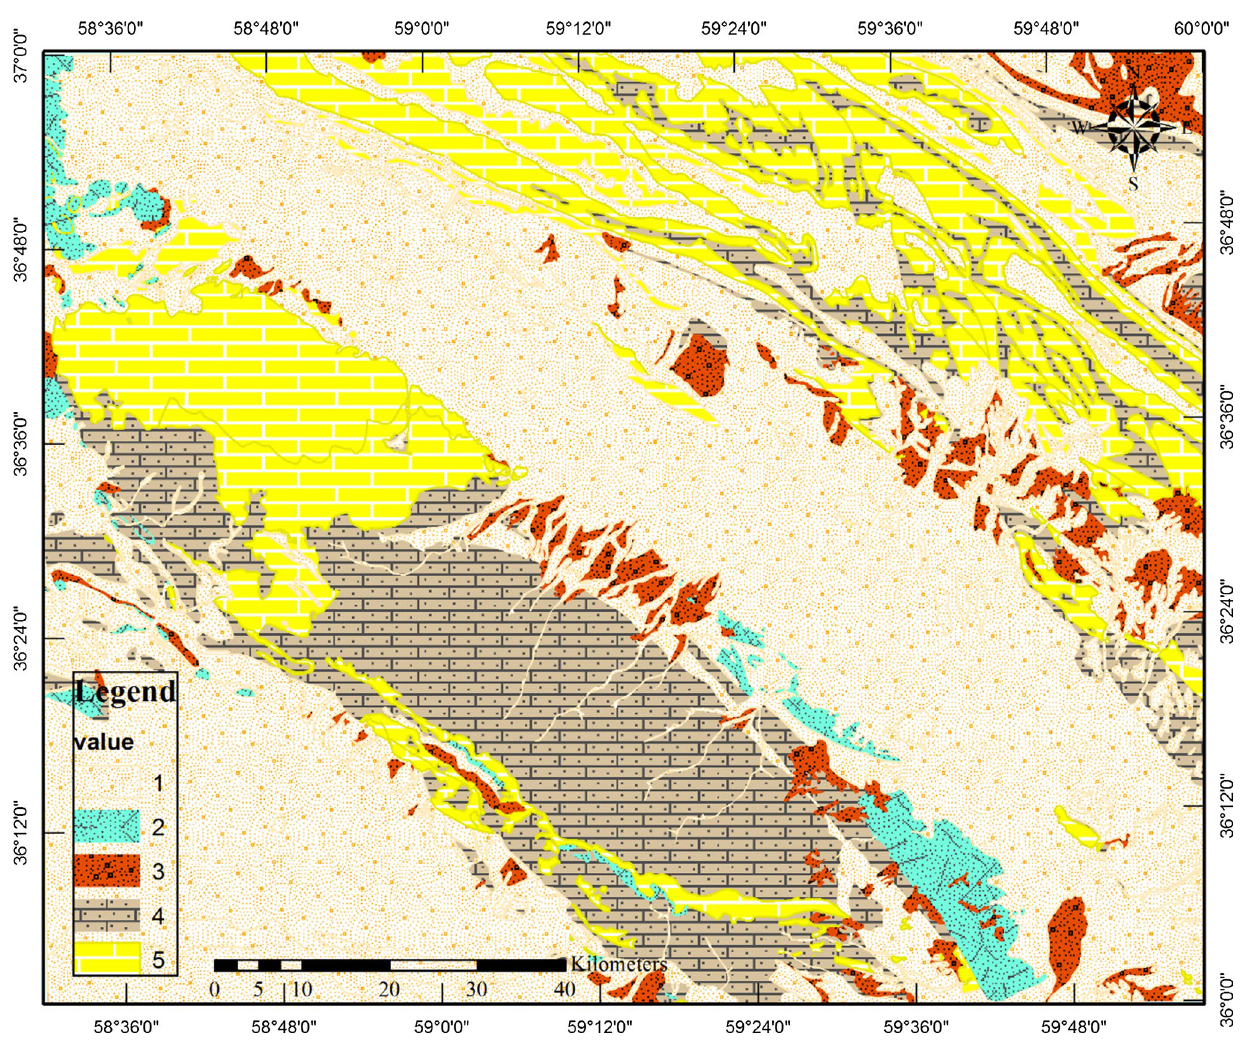
Fig. 5 Lithology map and values of the layers